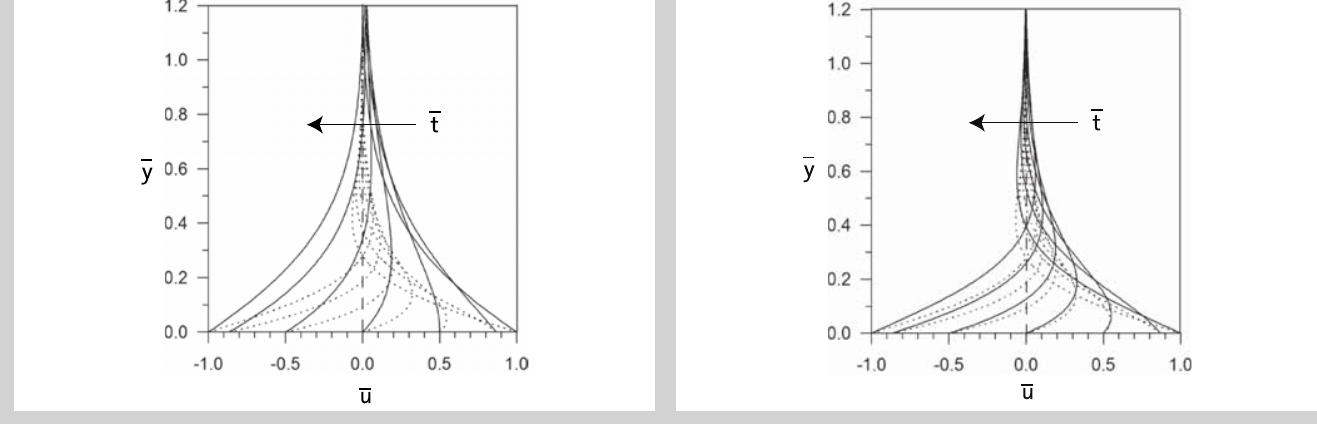
Figure 2: Calculated velocity profiles at different time slices: (a) b = b = b = b = 0.1 1 2 4 5 (b) b = 0.5 and 1 b = b = b = 0.1 2 4 5 (solid: present model, dotted: Newtonian